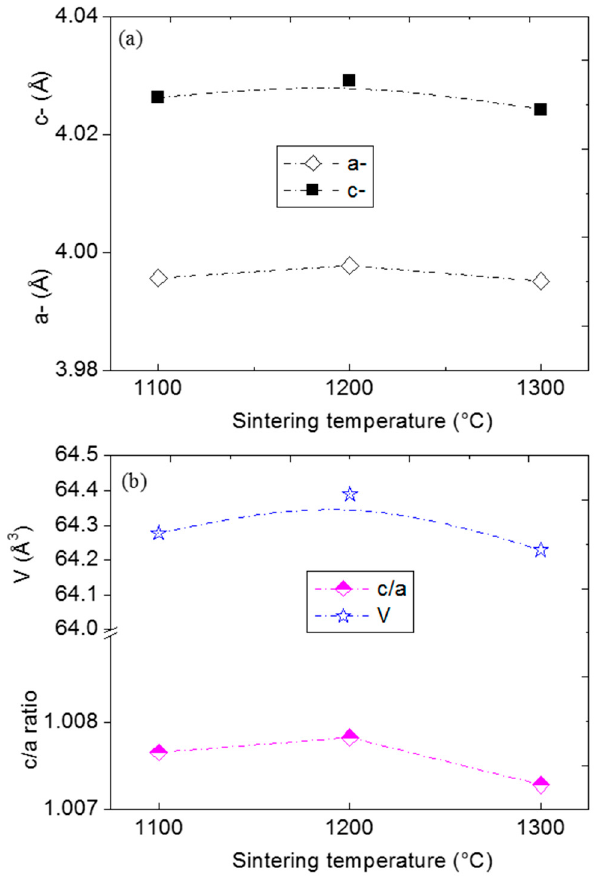
Figure 3. Variations of ( a ) lattice parameters and ( b ) unit volume cell and c/a ratio as a function of sintering temperatures.